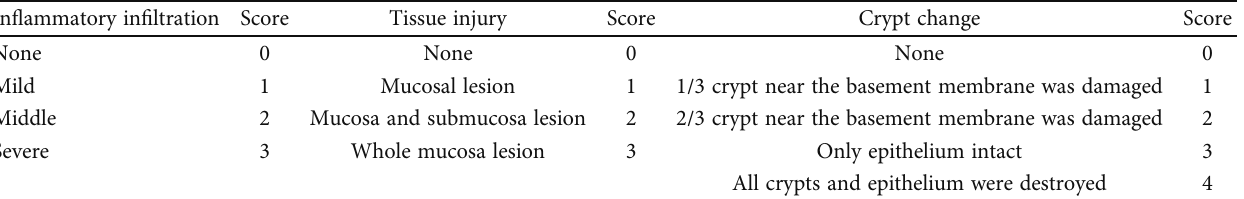
Table 2: H&E staining